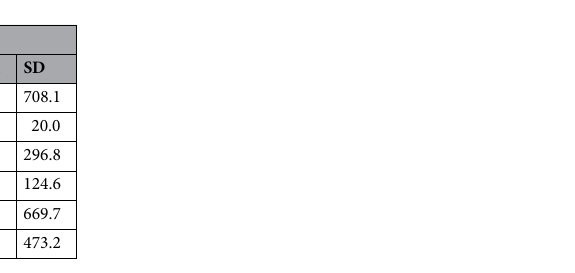
Table 3. Areas of feeding scars by Hylobius abietis on seedlings treated with treatments.